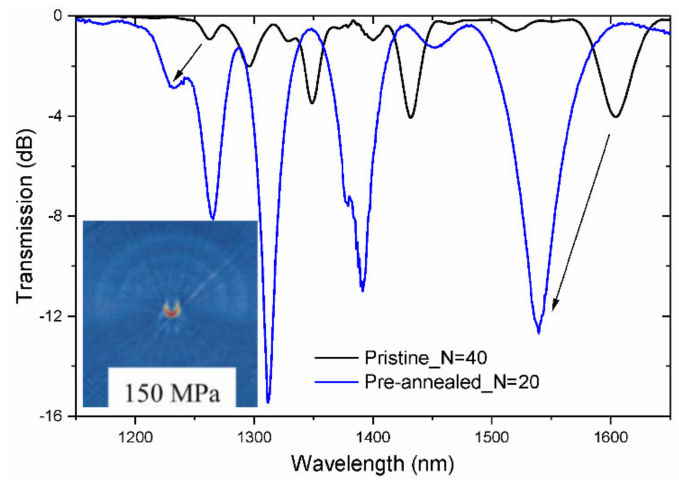
Figure 11. Spectra of gratings written in the pristine and pre-annealed fibre. Inset: Tomographic stress profile showing the “half-moon” stress induced in the core and inner cladding region of the pre-annealed by the arc discharge. Adapted with permission from ref. [123]. © 2006 IEE.